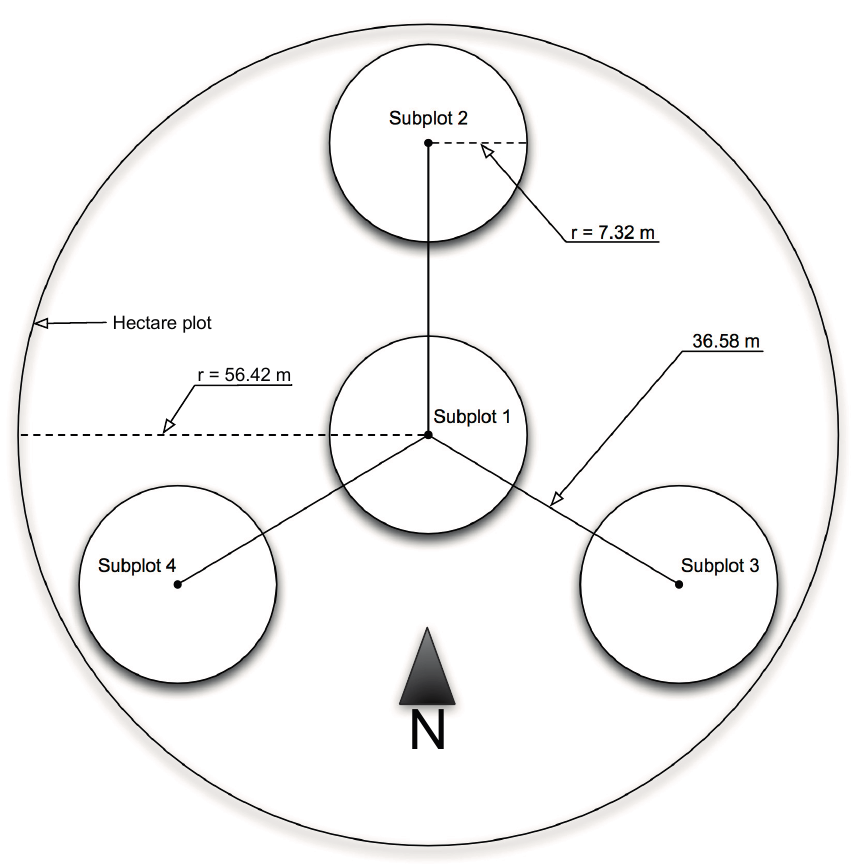
Figure 2. The location and dimensions of the subplots ( r = 7.32 m) and one-hectare ( r = 56.42 m) plot used by the Pacific Northwest Forest Inventory and Analysis region. Figure not drawn to